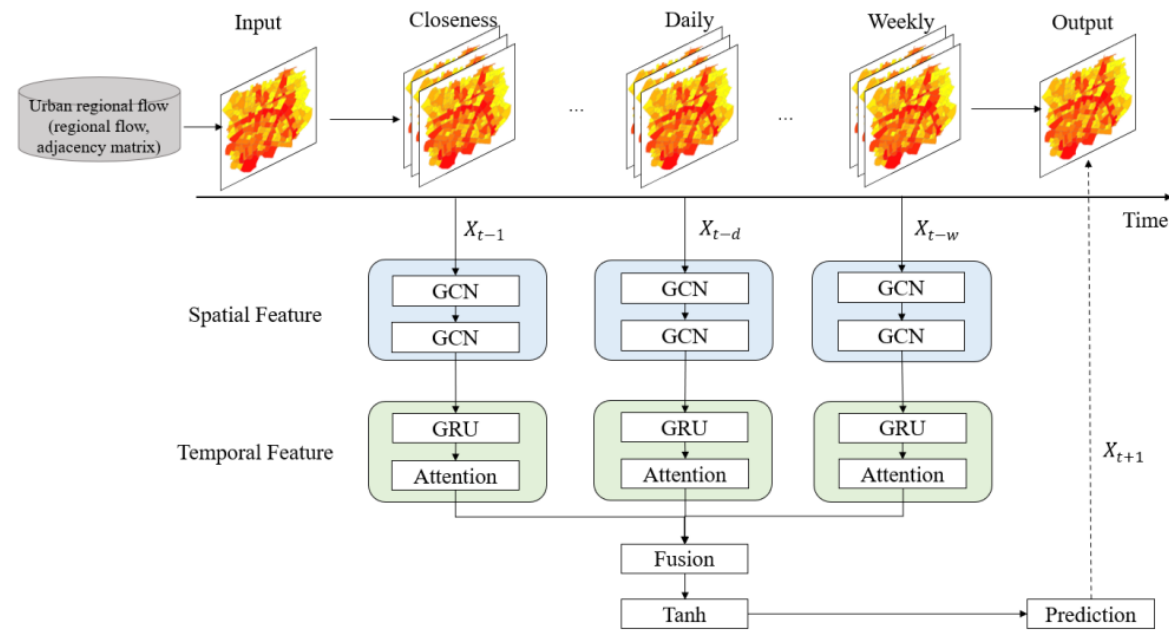
Figure 3. Framework of regional traffic flow spatiotemporal prediction model.